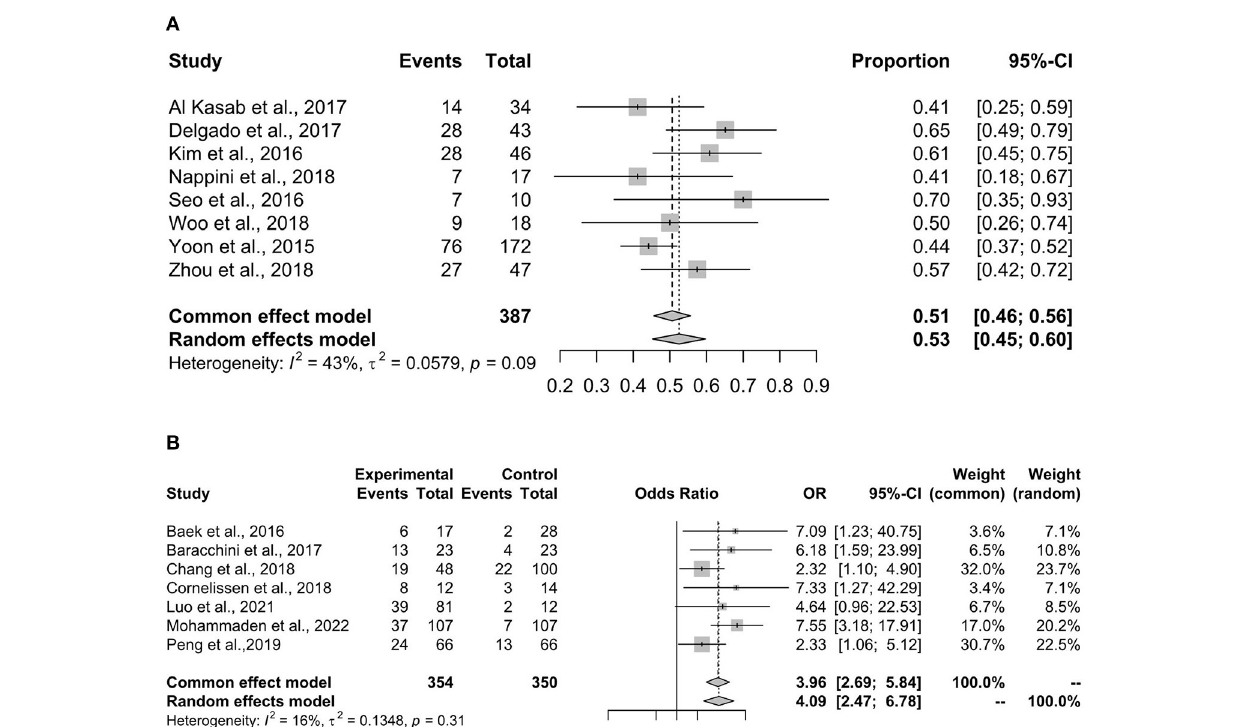
FIGURE1 Recanalization rate.